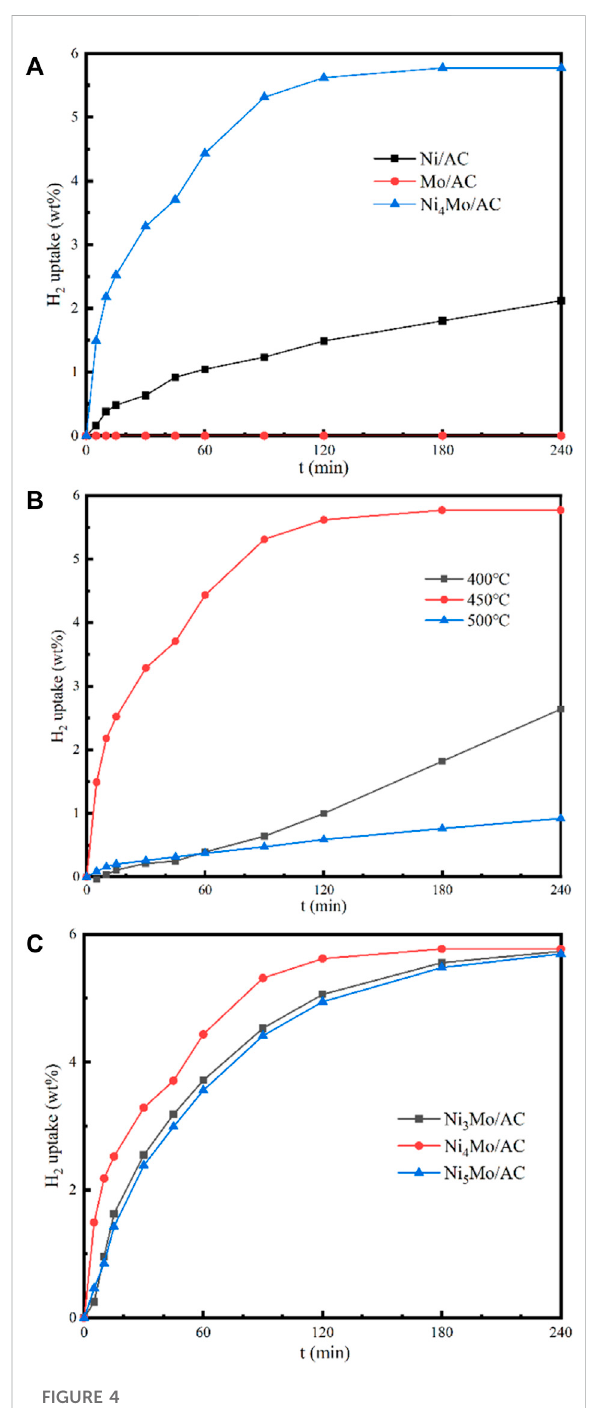
FIGURE 4 Hydrogenation kinetics of different catalysts. (A) Different loading metals; (B) Different reduction temperatures; (C) Different Ni/Mo